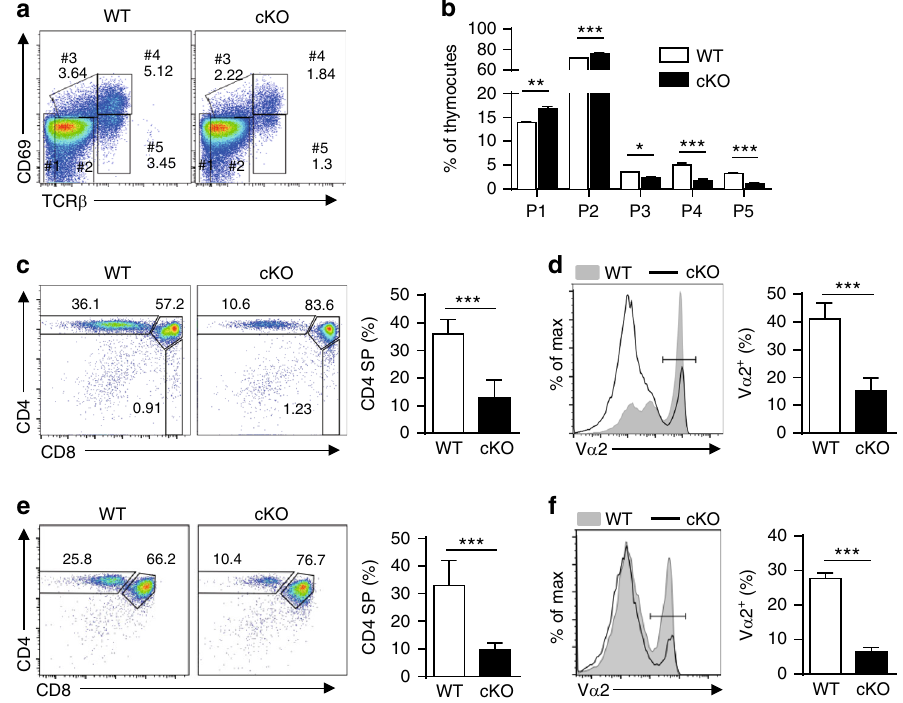
Fig. 2 NCoR1 de fi ciency leads to a blockade in positive selection. a The surface expression of CD69 and TCR β detected by fl ow cytometry on NCoR1- de fi cient (cKO) and wild-type (WT) thymocytes ( n = 5 for each group). b Quanti fi cation of each subpopulation gated in ( a ). c , e The expression pro fi les of CD4 and CD8 (left) on total thymocytes from cKO and WT OT-II TCR-transgenic mice in the Rag1 +/+ ( c , n = 4) or Rag1 − / − ( e , n = 3) background. The right panel shows the percentages of CD4 + single-positive (SP) thymocytes gated in the left panel. d , f The expression of TCR V α 2 detected by fl ow cytometry on total thymocytes from cKO and WT OT-II TCR-transgenic mice in Rag1 + / + ( d , n = 4) or Rag1 − / − ( f , n = 3) background. The right panel shows the quanti fi cation of TCR V α 2 + thymocytes gated in the left panel. The data are representative of three independent experiments ( a – f ). Statistical signi fi cance was analyzed using the two-tailed Student ’ s t test (* P < 0.05; ** P < 0.01; *** P <